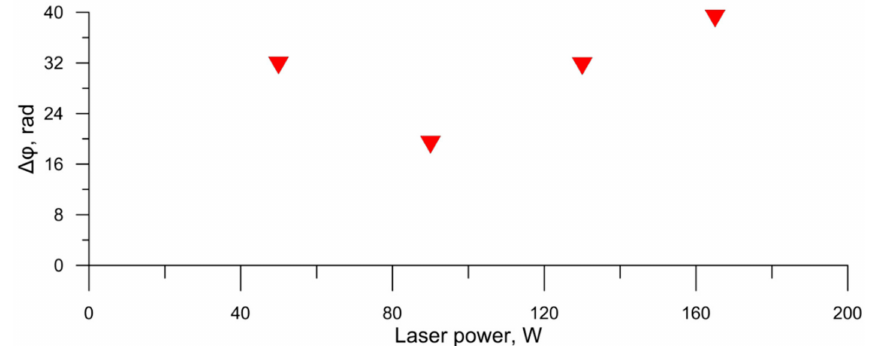
Figure 4. Interferograms of steady-state gas-phase flows at working laser powers (W): ( a ) 50, ( b ) 90, ( c ) 130, ( d ) 170.